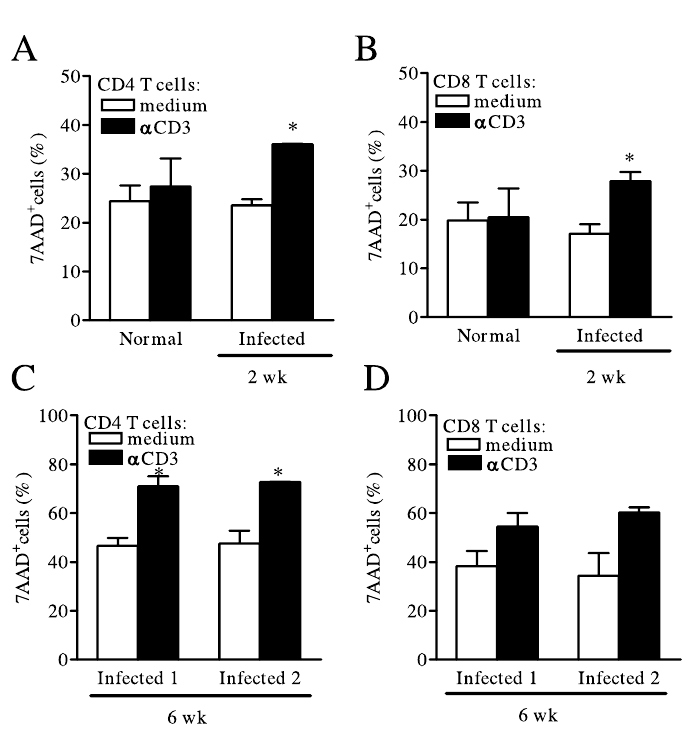
Fig. 2 – Activation-induced cell death upon infection with L. major . Lymph node cells from normal and L. major -infected mice were cultured in the presence of medium only (open bars) or stimulated with anti-CD3 (black bars). After 24 h, cells were stained with anti-CD4 (A and C), anti-CD8 (B and D), 7-AAD and evaluated by flow cytometry. Panels show percentages of apoptotic (7-AAD + ) CD4 and CD8 T cells upon 2 (A and B) or 6 (C and D) weeks of infection. Results are expressed as average and SEM. Significant differences between cells treated with medium and anti-CD3 were indicated for p < 0 . 05 ( ∗ )